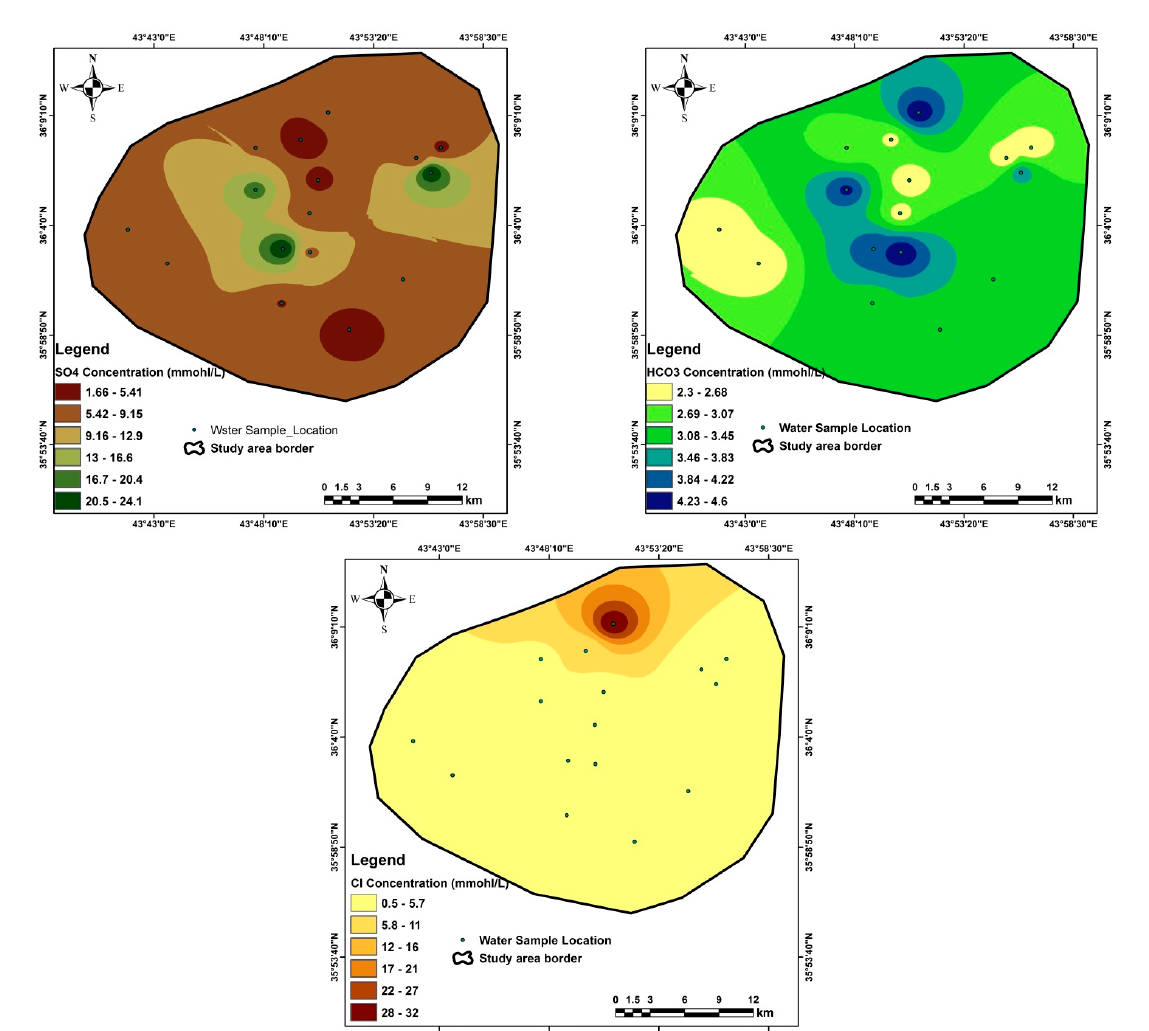
Figure A3. Special distribution of the anions in the study area.